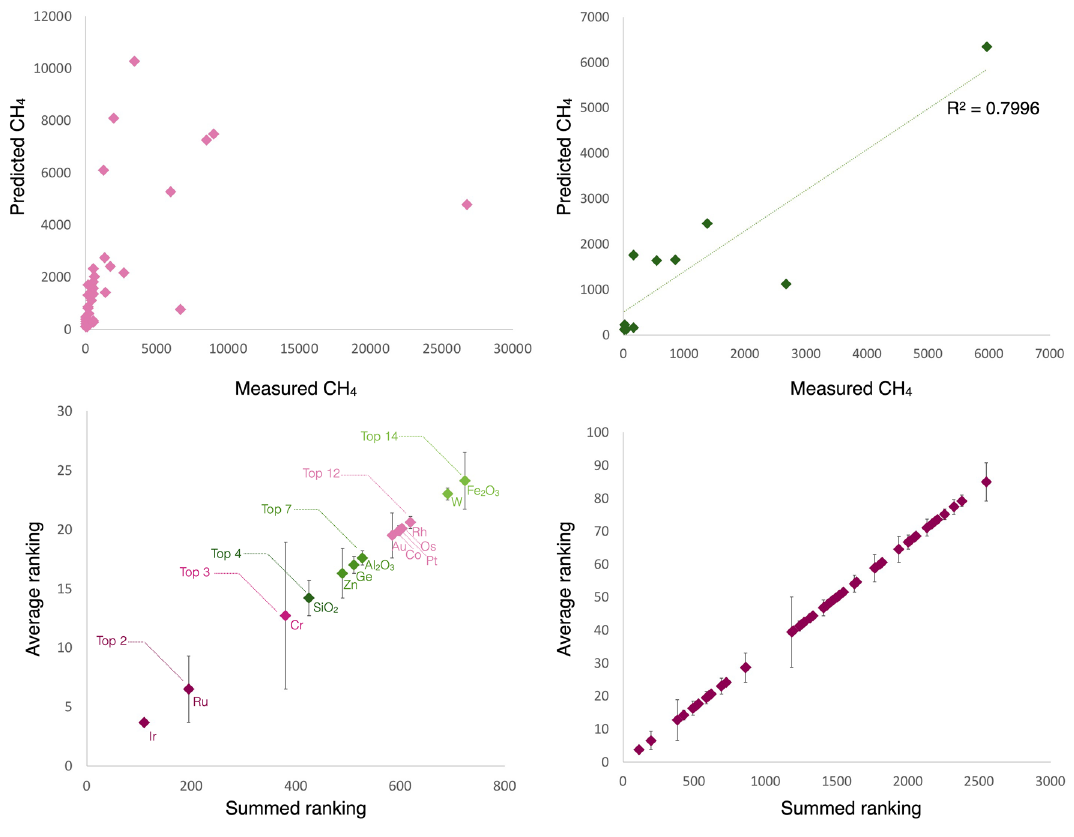
Figure 4. Random Forest Regression results . ( A ) Predicted and actual CH 4 values during training, ( B ) Predicted and actual CH 4 values during testing, ( C ) Top 14 features ranking, ( D ) All features